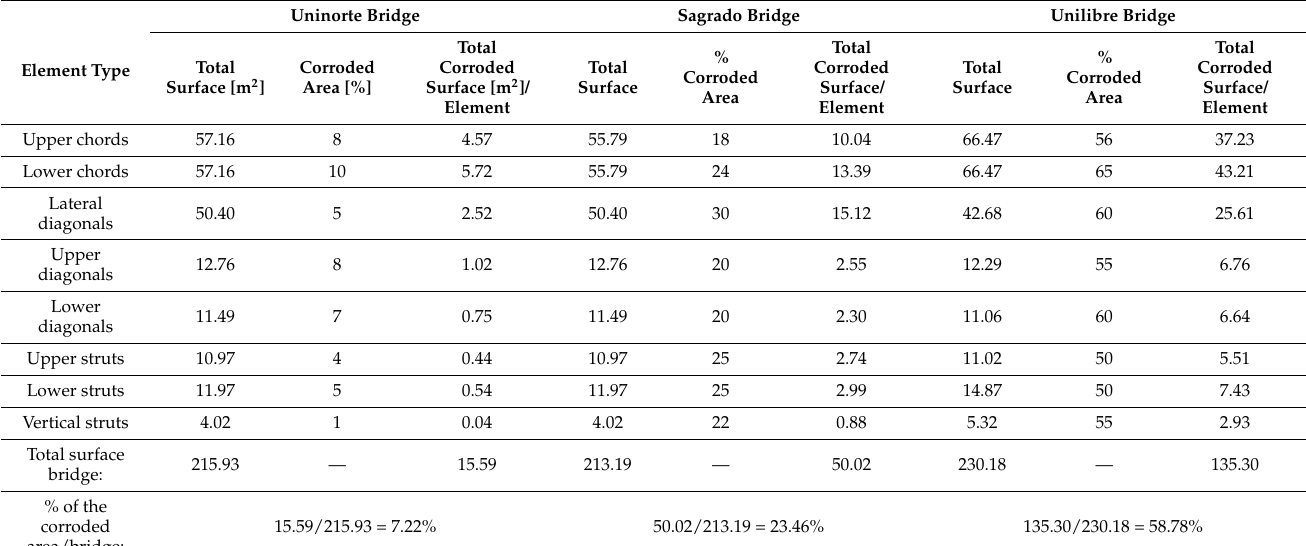
Figure 23. Relationship between the dynamic parameters and corrosion grade.